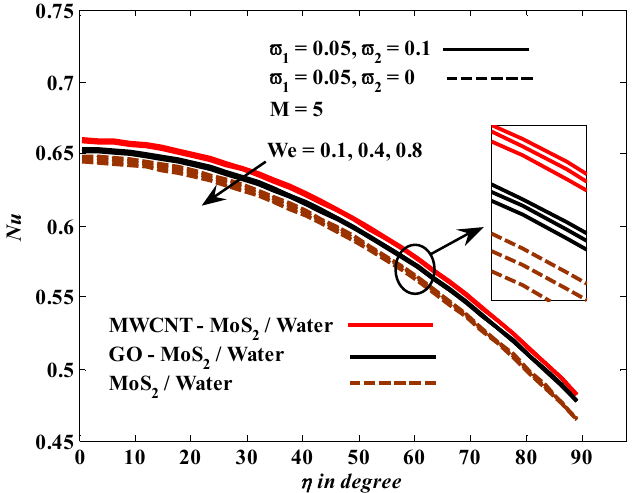
Figure 7. The behavior of hybrid nanofluid’s Nusselt number under the effect of We.